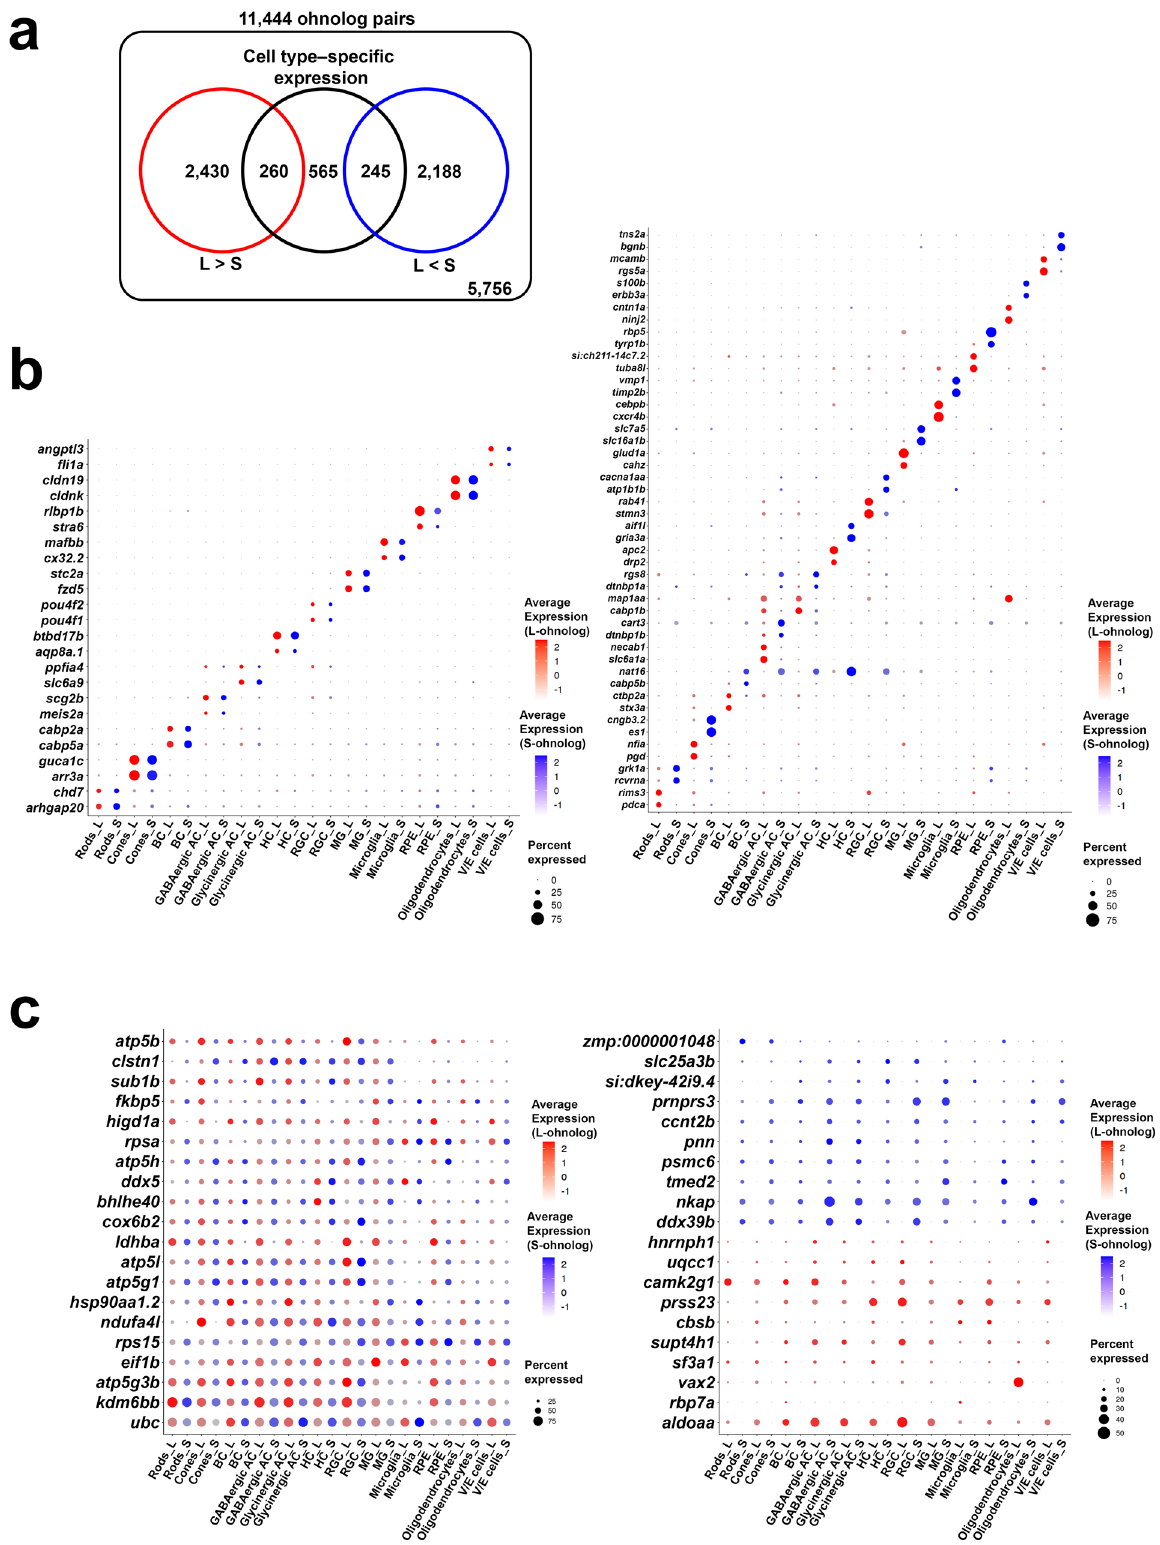
cell fate commitment (GO:0045165) (Fig. 4b; Supplementary Data 10). Some of those 295 biological categories shared similar ohnolog pairs. We generated an enrichment network based on their membership similarities where nodes represented biological categories and edges represented membership similarities with statistical signi fi cance. The resulting enrichment